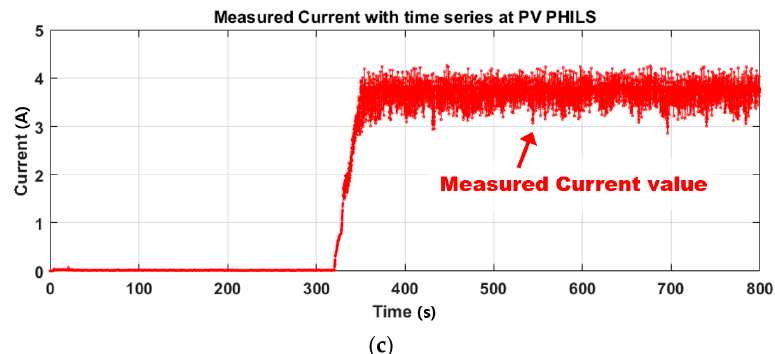
Figure 13. Experiment result with the conventional operation algorithm of the PV PHIL Simulator (PHILS). ( a ) I-V Curve characteristic graph of the PV System ( b ) DC power supply voltage output with time series ( c ) DC power supply current output with time series.